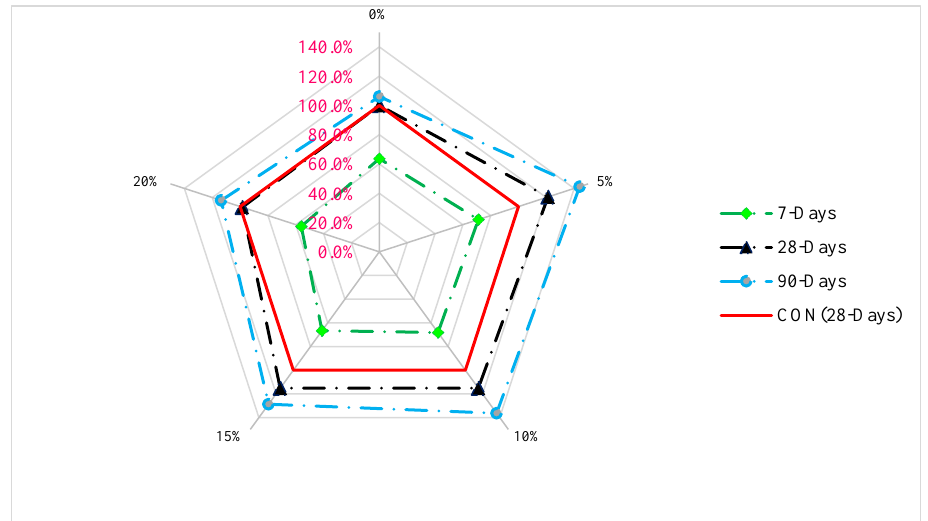
Figure 5. Compressive strength age relation [10].